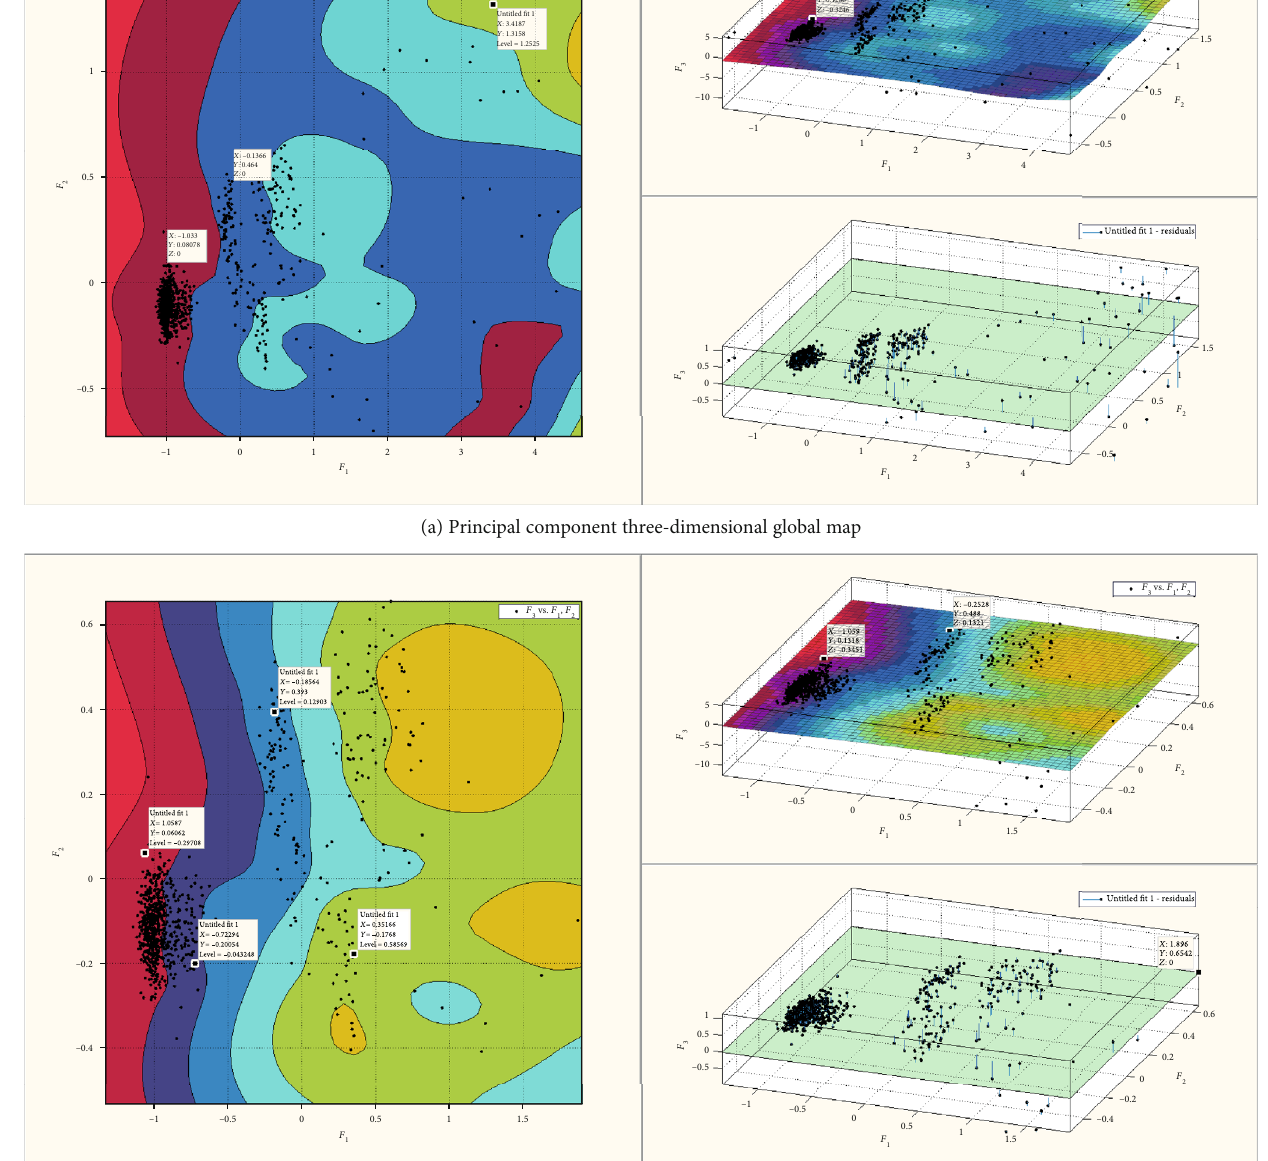
Figure 9: Three-dimensional contour map of principal components F